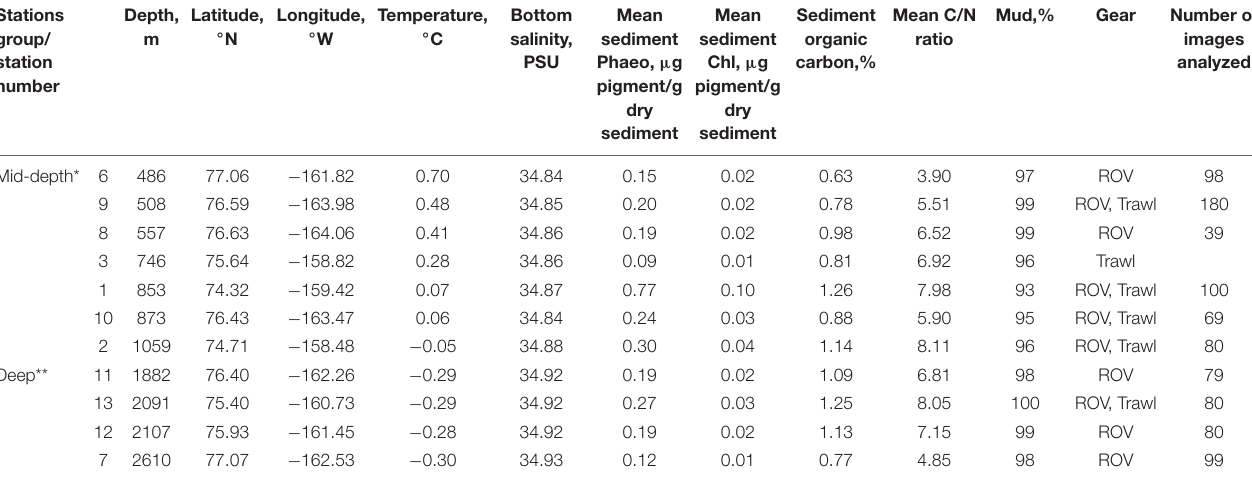
TABLE 1 | Station information for ROV images and beam trawl samples collected in the Arctic Chukchi Borderland. Stations Depth, Latitude, ◦ group/ m station number